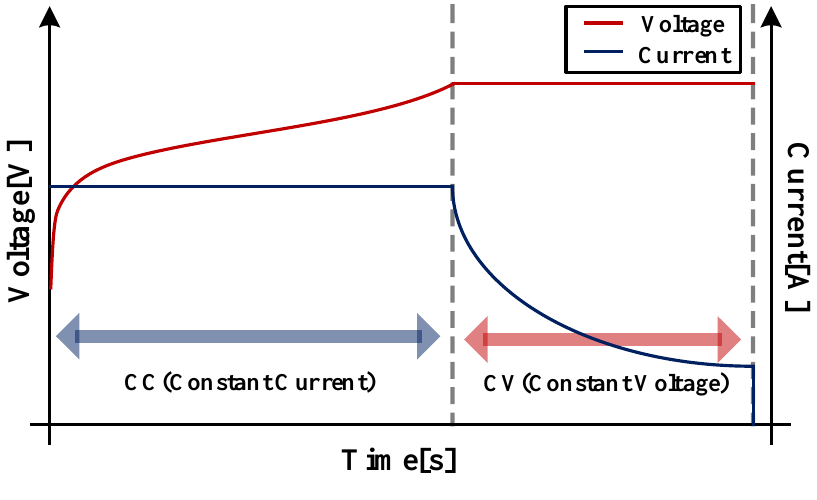
Figure 5. CC-CV charge control of battery.